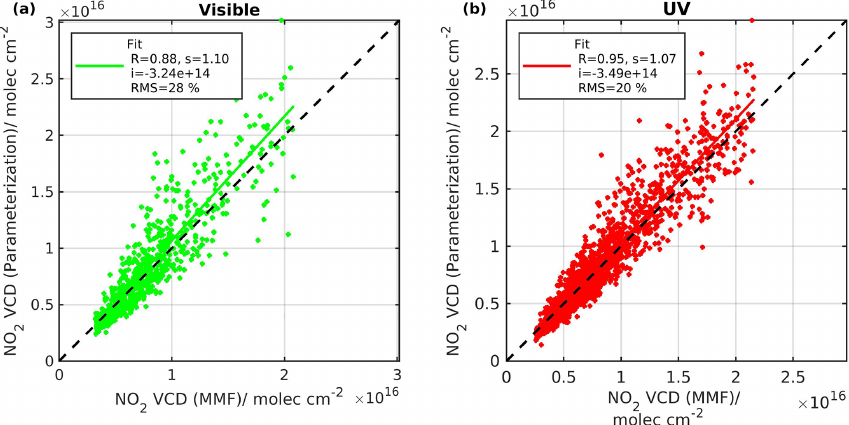
Figure 8. Comparison between MMF and parameterized NO 2 VCD at 477nm (visible, a ) and 360nm (UV, b ), as derived from the main azimuthal direction (i.e., 35.5 ◦ azimuthal